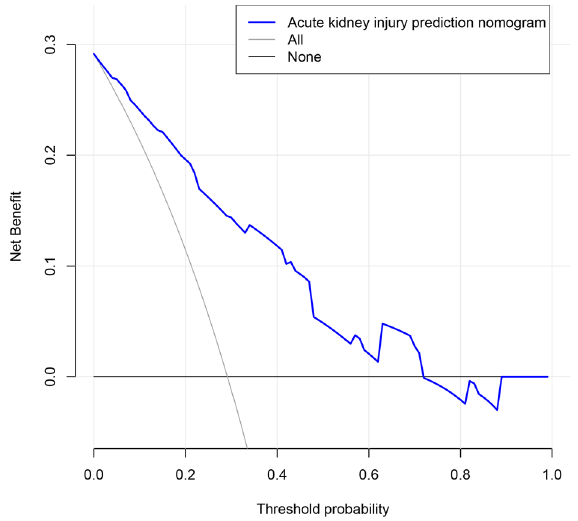
Figure 6. The nomogram of the decision curve analysis and the net benefit of the model ranged from 0.01 to